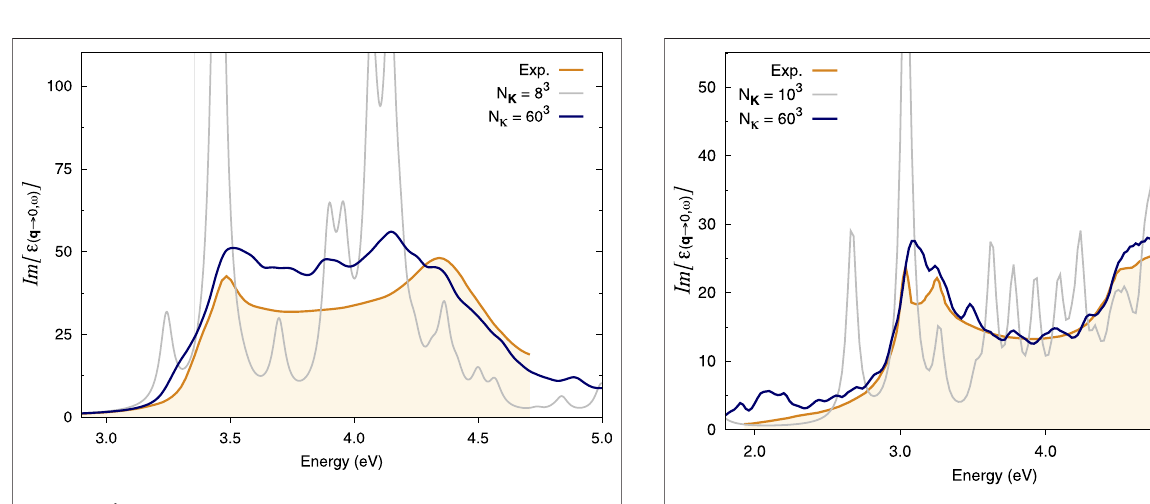
FIGURE 2 | Optical absorption spectra of bulk GaAs. BSE spectra calculated using the double-grid approach described in this work are assessed against the experimental spectrum at 22 K from Lautenschlager et al. (1987). Spectra are calculated on a 10 × 10 × 10 coarse k -grid and a denser fi ne k -grid, indicated by N κ . N K (cid:2) 10 3 corresponds to a standard calculation on a 10 × 10 × 10 k -grid while N κ (cid:2) 60 3 corresponds to a double- gridcalculationwitha60 × 60 × 60 fi negrid.Weconsiderall e − h pairsfromthe top four valence bands to the four bottom conduction bands. All k -grids are